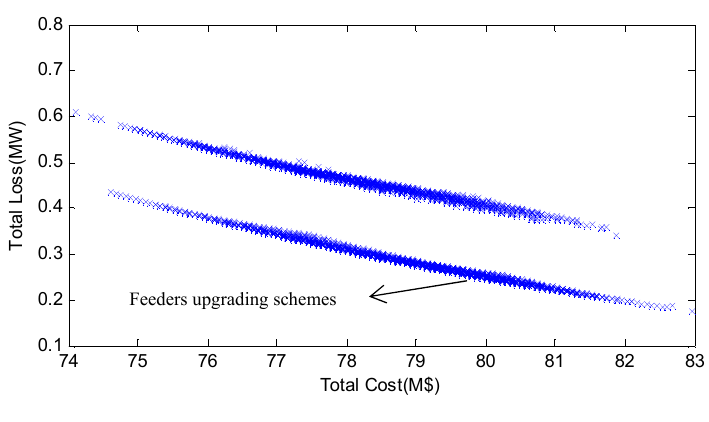
Figure 9. Costs, losses projection graph.